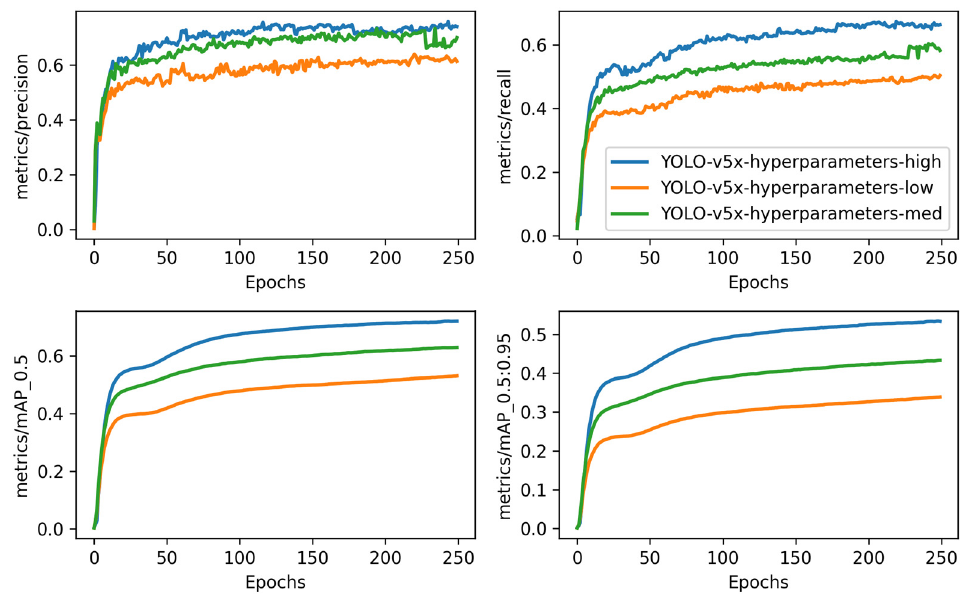
Figure 14. Evaluation prediction performance of the proposed VPP framework using three different hyperparameters and initialization strategies: hyp.scratch-low, hyp.scratch-med, and hyp.scratch-high.